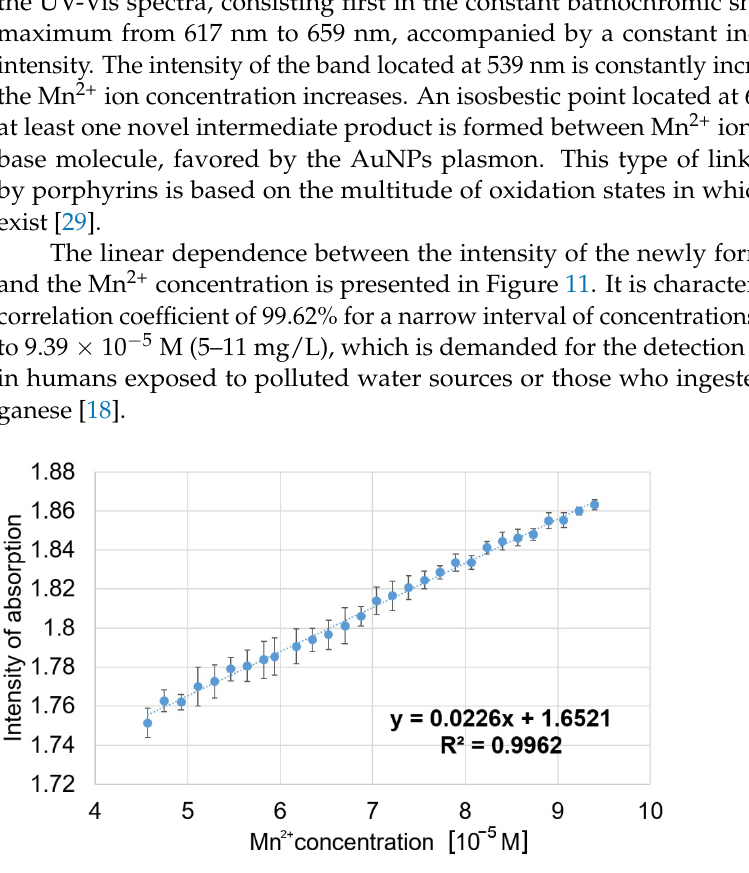
Figure 11. Linear dependence between the intensity of absorption of (5-COOH-3MPP)-k-carrageenan- AuNPs hybrid material measured at 659 nm and the Mn 2+ ion concentration.